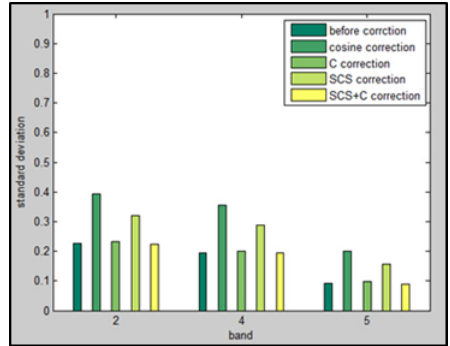
Figure 5. Standard deviation